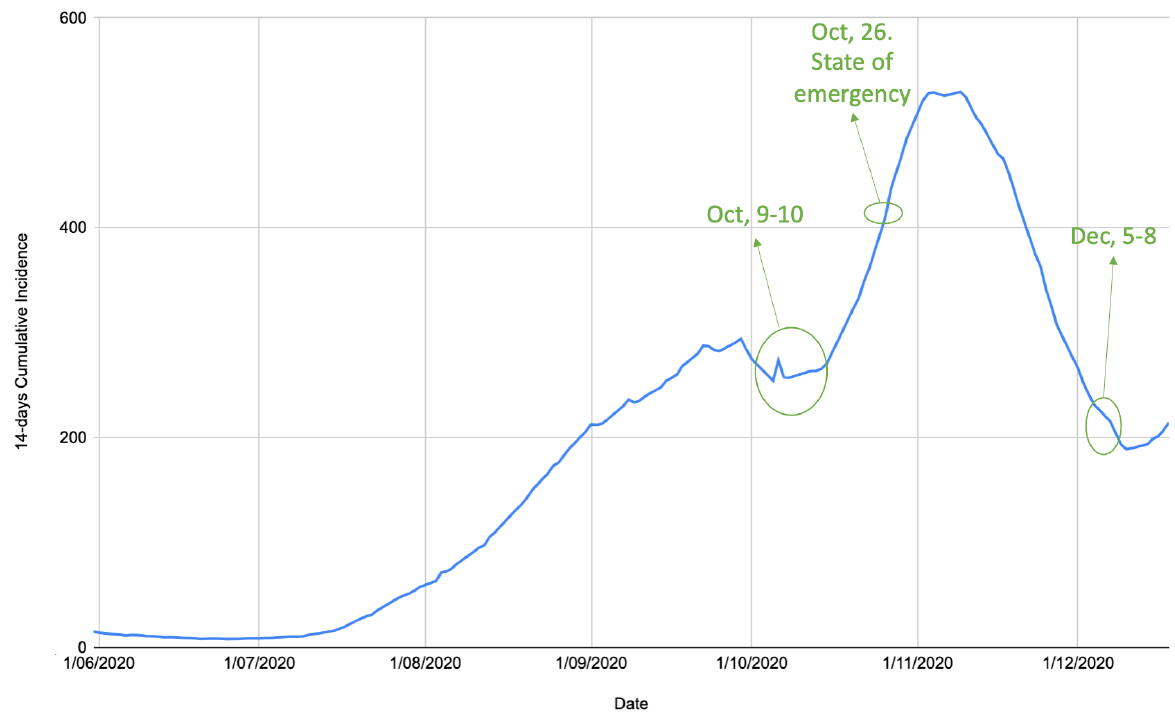
Figure 6. 14-day cumulative incidence (CI) in Spain. Holidays and the declaration of the emergency state are